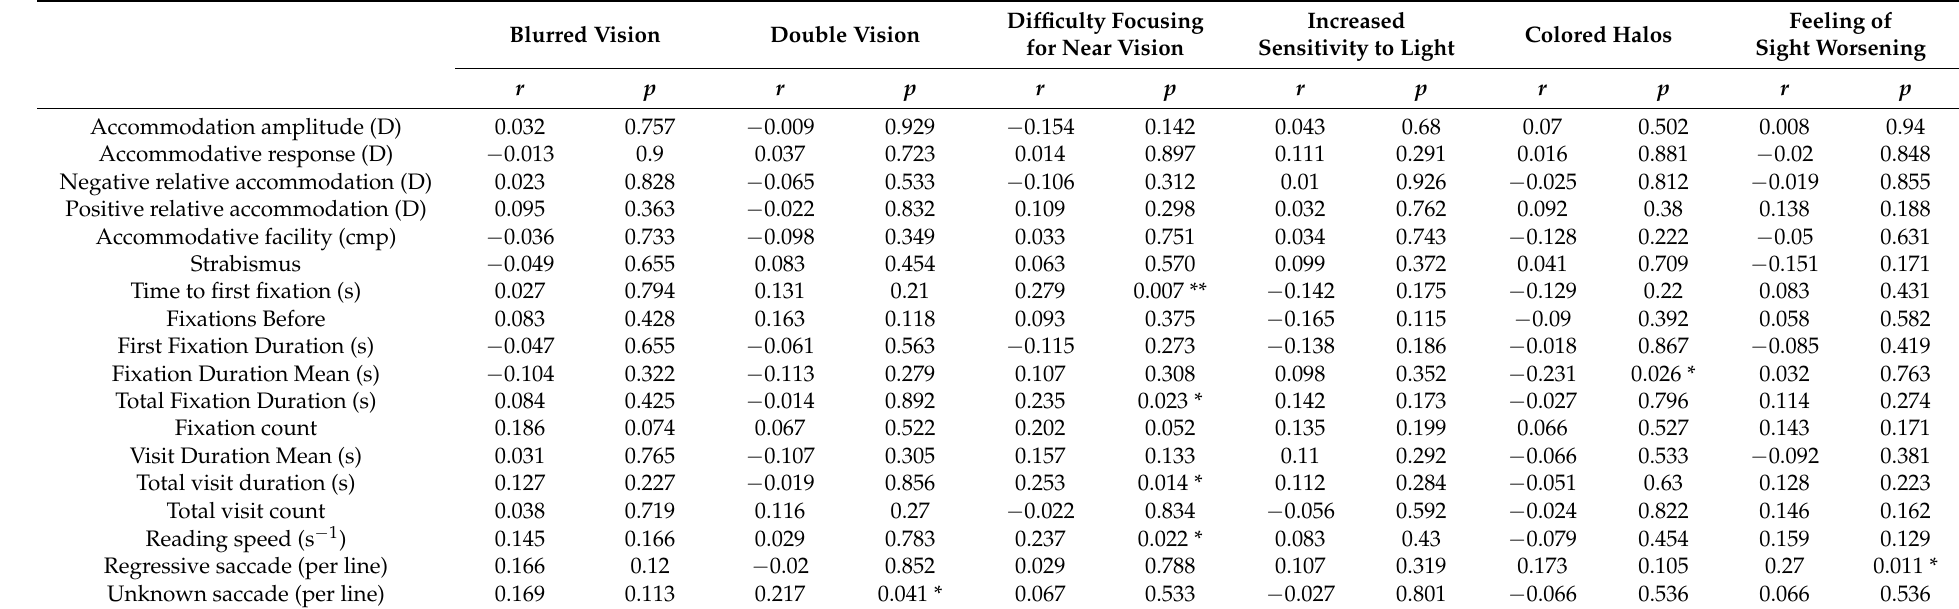
Table 2. Correlations of visual disturbance and accommodation and eye movement.